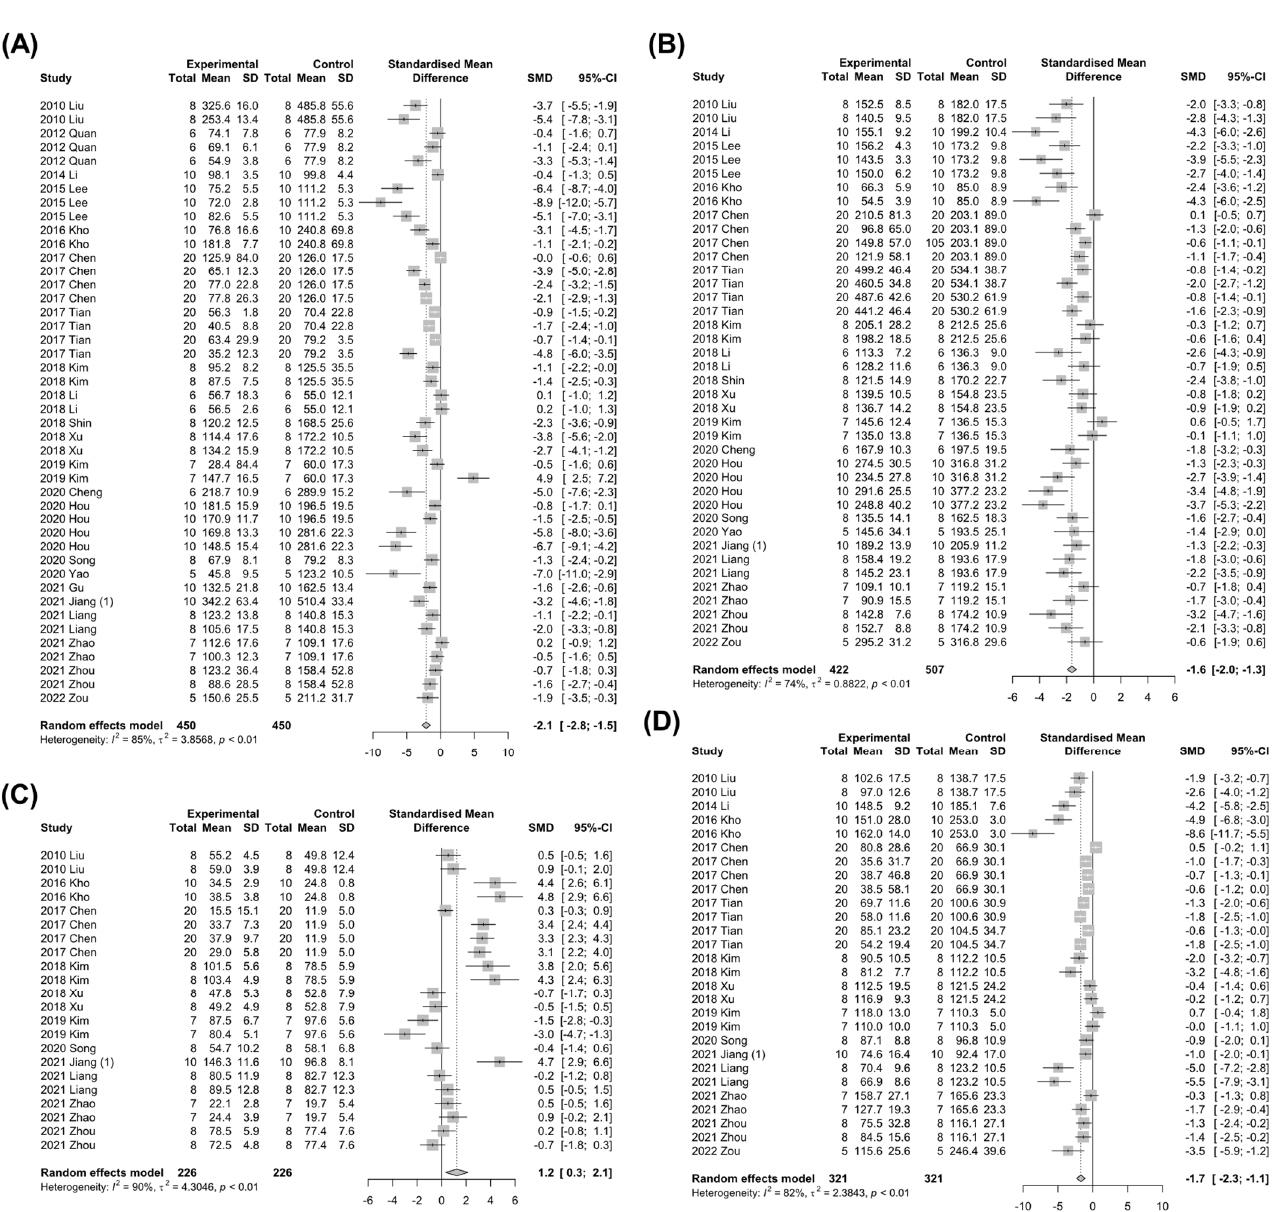
Figure 6. Effects of Panax ginseng on markers for hepatic lipid metabolism in the subgroup analysis of HFD-induced NAFLD. Forest plots for comparison: ( A ) TG levels [7,21,22,25–28,30,32–35,39–41,46–49,51,52,57]. ( B ) TC levels [7,21,25–28,30,32–35,39–41,46,47,49,51,52,57]. ( C ) HDL levels [7,21,27,28,32,35,39,46,49,51,52]. ( D ) LDL levels [7,21,25,27,28,30,32,35,39,46,49,51,52,57]. SD, standard deviation.